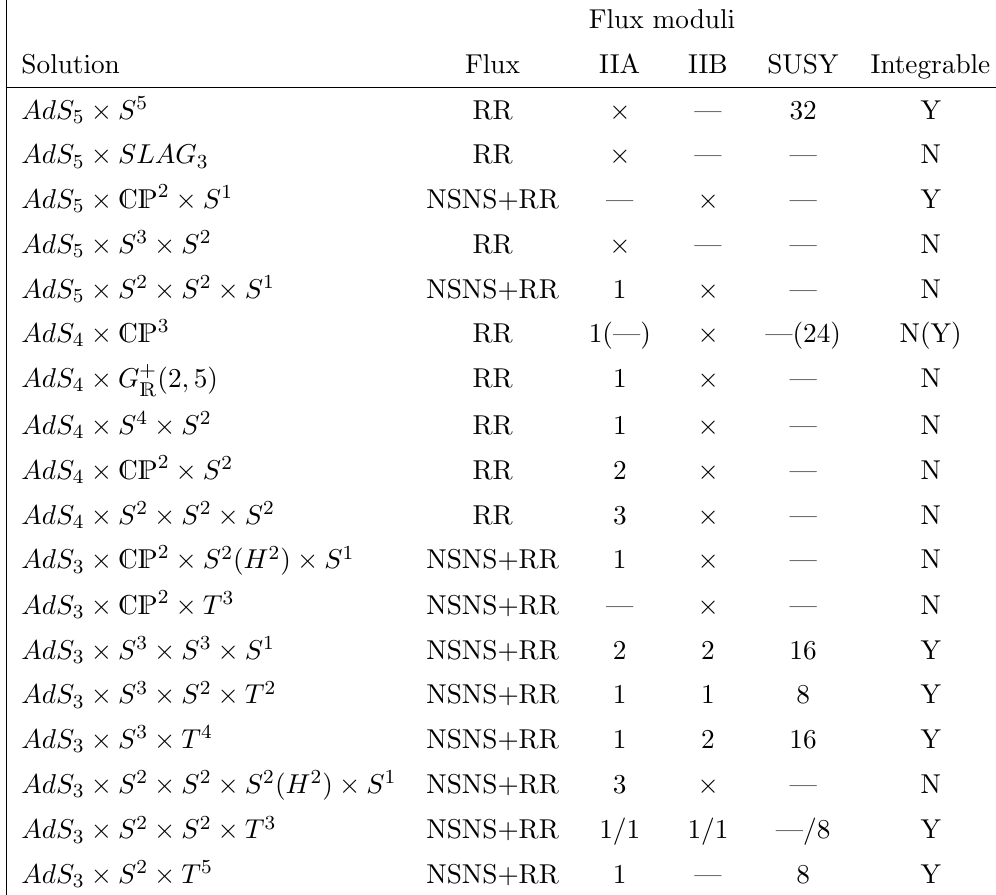
Table 1 . The symmetric space AdS n backgrounds for n > 2 whose integrability was not previously ruled out. The type of (cid:13)ux and the number of free parameters entering the (cid:13)uxes (not counting the AdS radius) are given for the type IIA and type IIB solution respectively with ‘|’ denoting no free parameters and ‘ (cid:2) ’ denoting that no solution exists. The number of supersymmetries preserved by the solution is also given. When there is both a type IIA and type IIB solution they are related by T-duality. AdS 3 (cid:2) S 2 (cid:2) S 2 (cid:2) T 3 has a supersymmetric and a non-supersymmetric branch while AdS 4 (cid:2) CP 3 has a subbranch which is supersymmetric. Here SLAG 3 = SU(3) = SO(3) and G + R (2 ; 5) = SO(5) = U(2). The ‘N’s in the last column are the main result of this